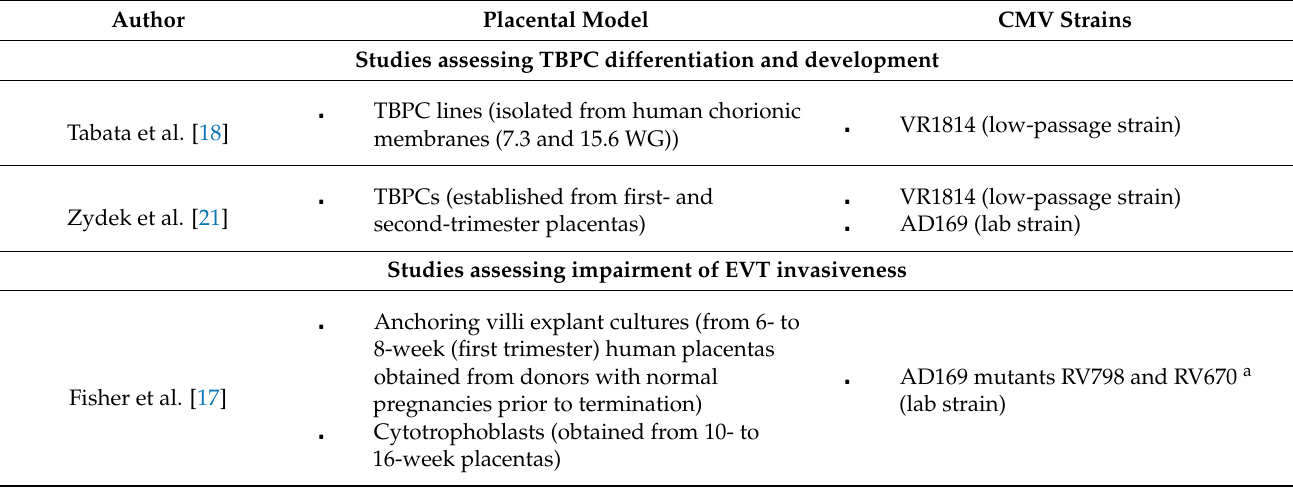
Table 2. Placental models and CMV strains used in the identified